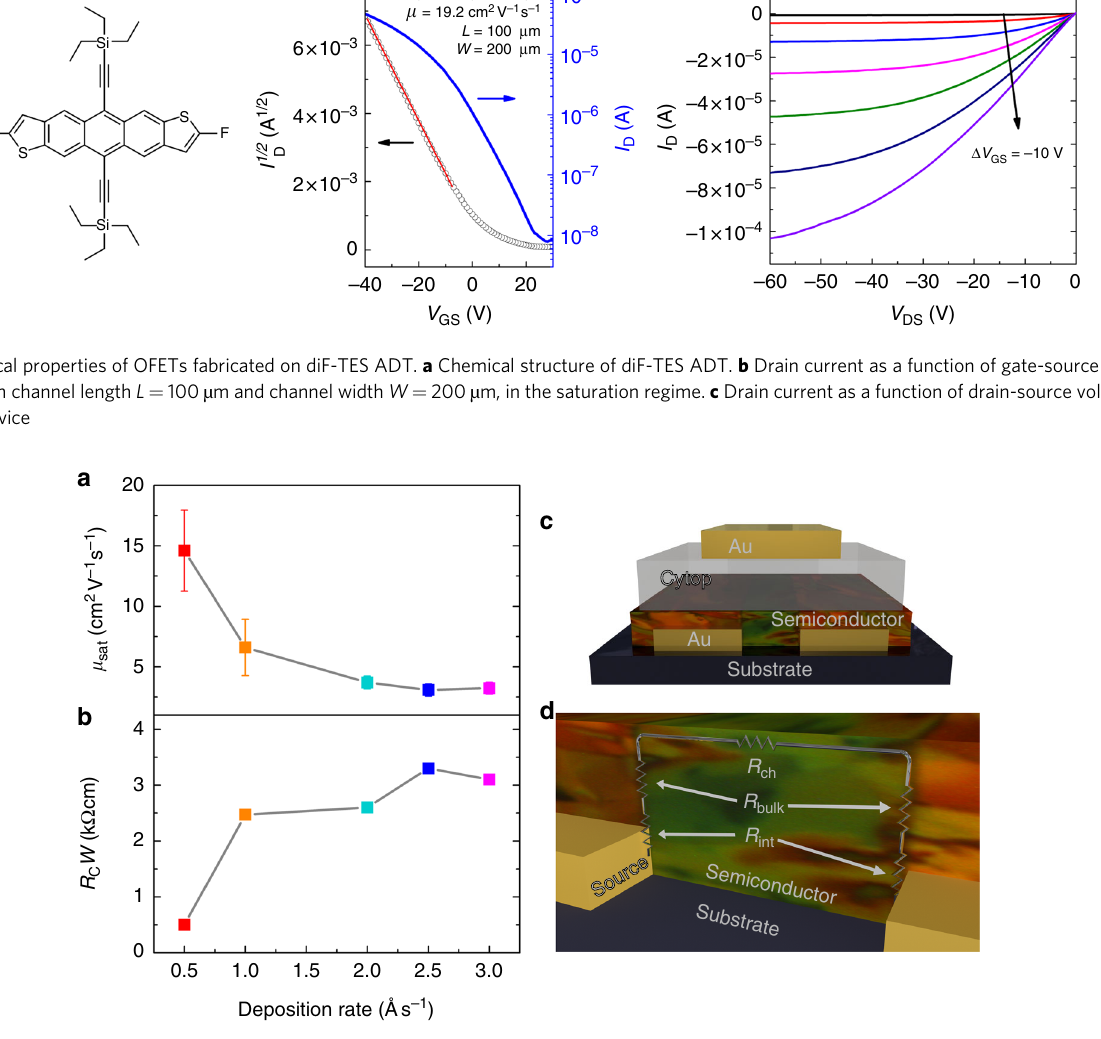
Fig. 2 Contact resistance in OFETs. a Average fi eld-effect mobility versus contact deposition rate. b Width-normalized contact resistance as a function of contact deposition rate. c Schematic of the bottom-contact, top-gate device structure used in our devices. d Equivalent circuit diagram including the different sources of resistance in our devices